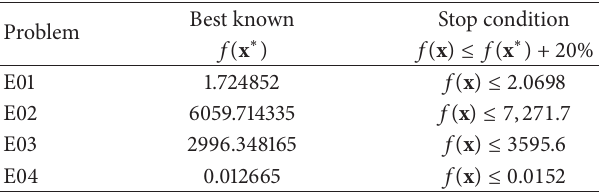
Table 7: Stop condition used in